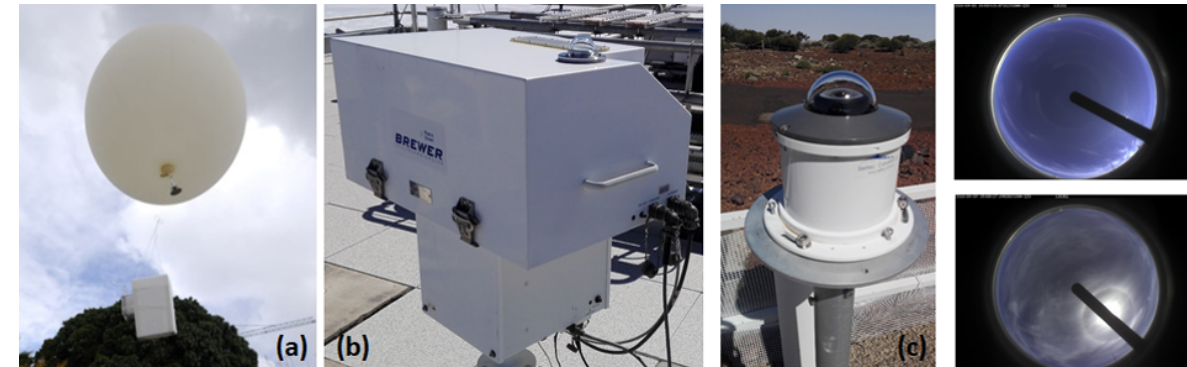
Figure 4. Other instruments currently providing data to IZA BSRN: (a) radiosonde profiles, (b) the Brewer spectrophotometer and (c) SONA camera (automatic cloud observation system) installed at IZA and examples of images taken by the SONA camera.